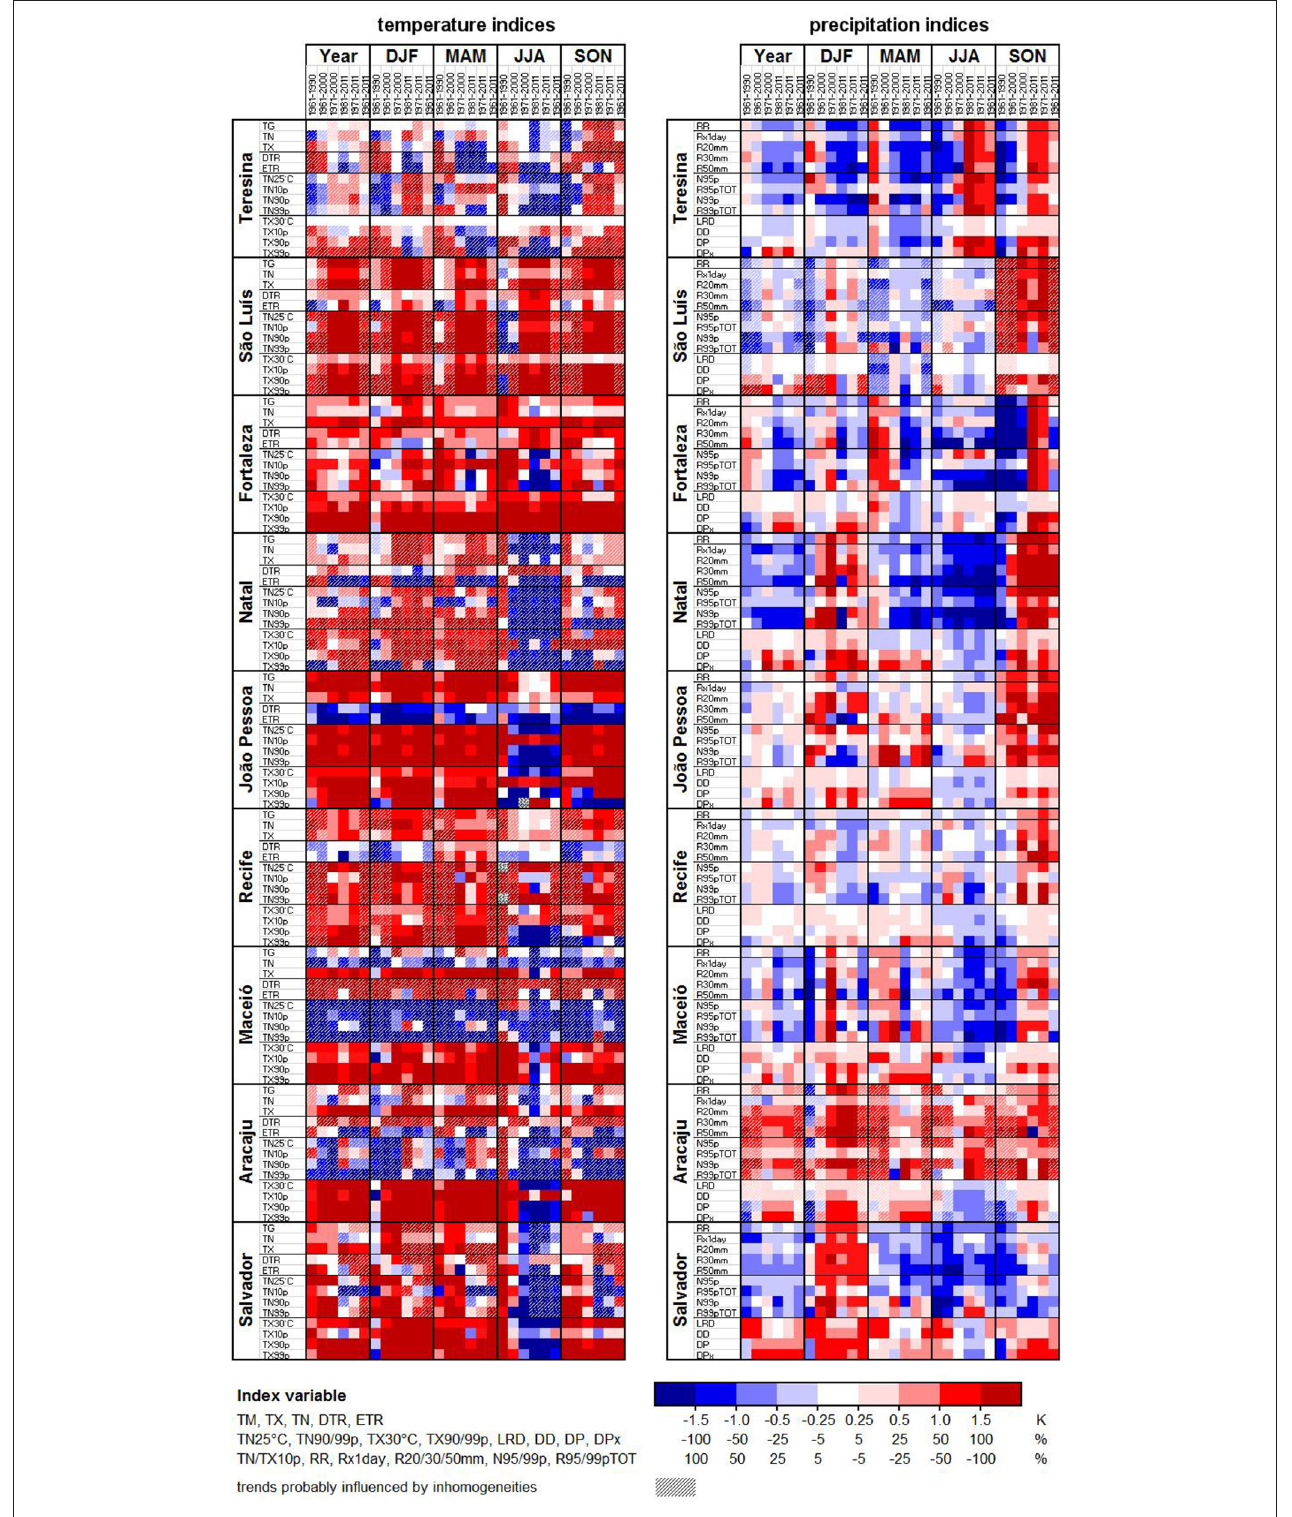
FIGURE 6 | Annual and seasonal trends in 13 temperature (left) and 13 precipitation (right) indices (see Table 1 for index explanation) for six analysis periods of 30–51 years duration (sub-columns of the season columns: 1961–1990/2000/2011, 1971–2000/2011, 1981–2011) at nine stations in NEB. The trend values are illustrated by a color scale (see legend) from blue (colder, wetter) over white (no change) to red (warmer, drier). Trends assessed to be unreliable due to data quality problems are faded out by white hatching.